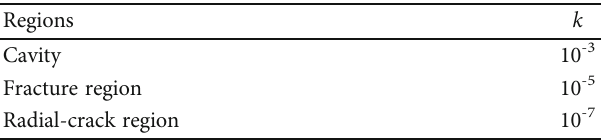
Table 1: Orders of magnitude of the energy factors of di ff erent